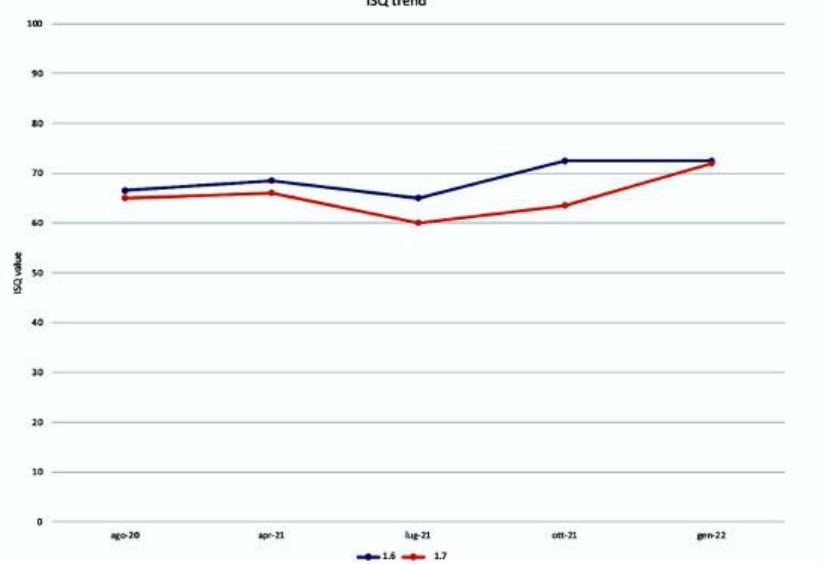
Figure 17. ISQ trend from the moment of implant application up to the moment of prosthetic fina- lization.